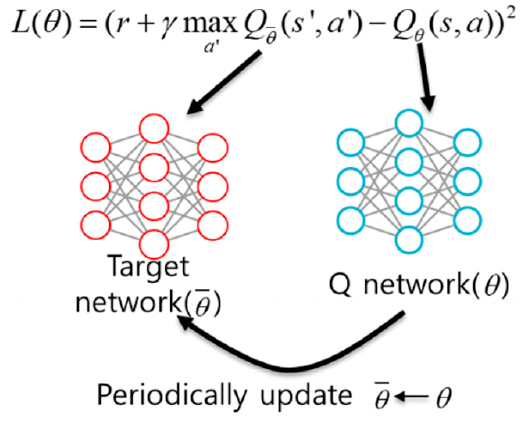
Figure 4. Target network separation.